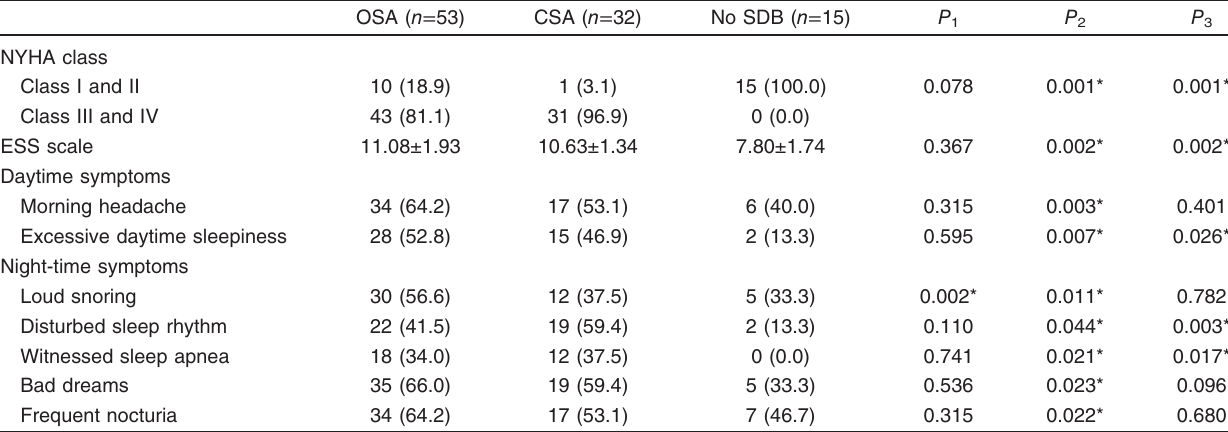
Table 3 Clinical scores for heart failure and sleep disorders between obstructive sleep apnea, central sleep apnea, and no sleep- disordered breathing in heart failure patients